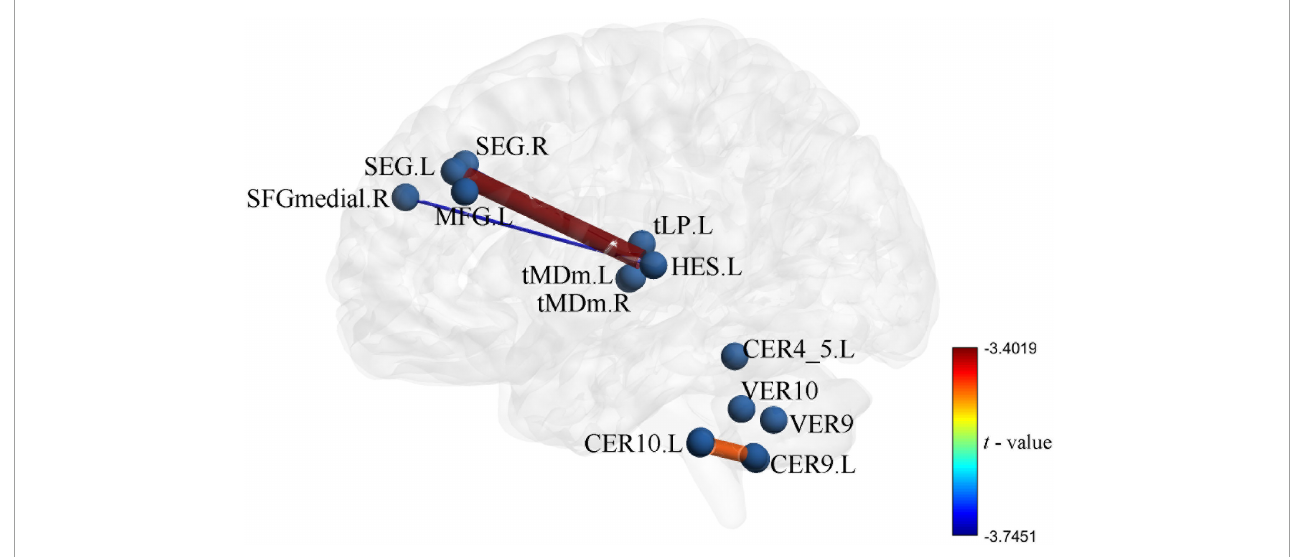
FIGURE4 Intergroup differences in functional connectivity between Parkinson’s disease (PD) and healthy controls (HC) groups the zFC pattern of 4 function connectivitys (FCs) between PD and HC, these FCs were significantly correlation in DC and uric acid (UA).